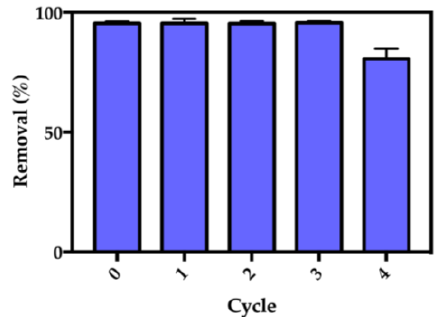
Figure 9. The reuse performance of the Fe 3 O 4 @SiO 2 /SiCRG hybrids in the removal of paraquat from water.